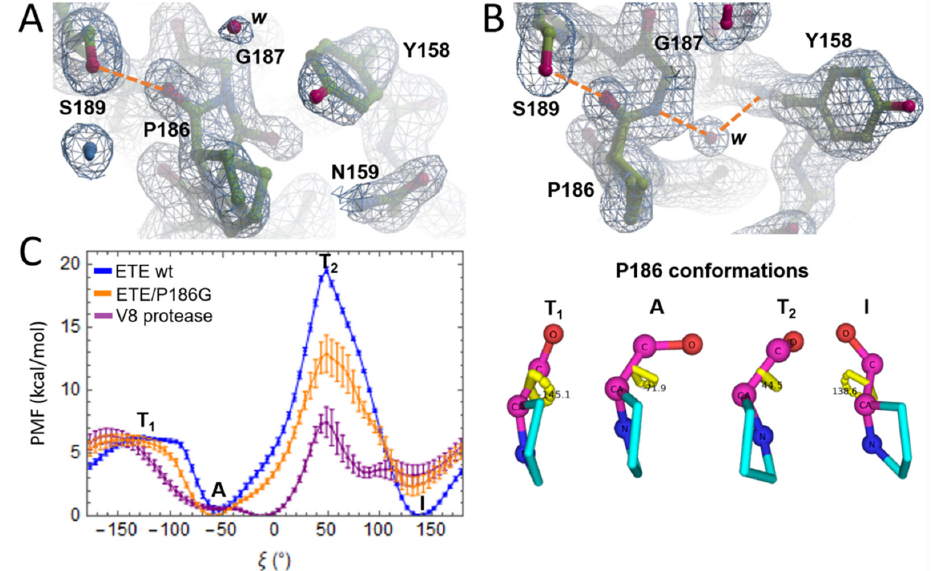
Figure 2. Crystallographic and energetic evidence of P186 dynamic flip in ETE. ( A ) Electron density map of the three-dimensional (3D) structure of ETE (PDB: 8DAX, chain A) showing the occurrence of a 180° flip of P186(O). ( B ) Electron density map of the 3D structure of ETE (PDB: 8DAX, chain B) showing conformation I of P186(O). Residues are labeled and represented as sticks. The electron density is represented as a mesh. H-bonds are depicted as orange dashed lines. Crystallographic water molecules are identified with the letter w. ( C ) PMFs for the 360° rotation around the N-CA-C-O dihedrals ( ξ ) of P186 of ETE wt, G186 of ETE/P186G mutant and G166 of V8 protease (see color legend). The two minima correspond to conformations A and I and the two maxima, T 1 and T 2 , to the associated energy barriers (see the corresponding P186 conformations on the right panel). Equivalent conformations of G186 and G166 are not shown for brevity’s sake.